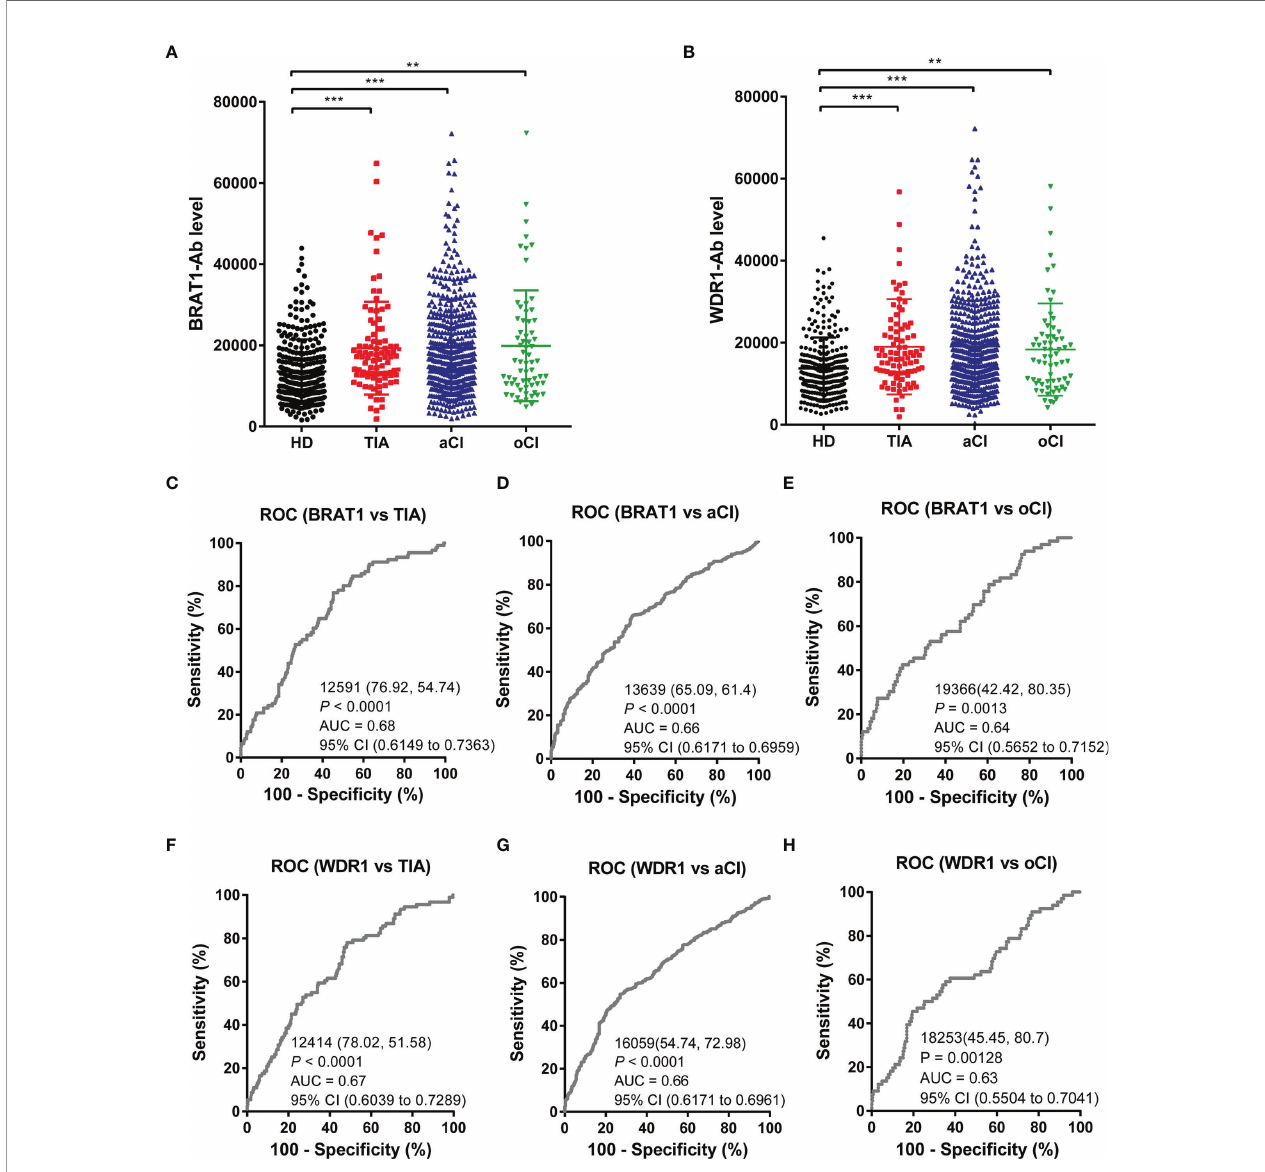
FIGURE 2 | Comparison of serum anti-BRAT1 antibody (BRAT1-Abs) and anti-WDR1 antibody (WDR1-Abs) levels between healthy donors (HDs) and patients with TIA, aCI, or oCI. Serum antibody levels against BRAT1-GST (A) or WDR1-GST (B) were determined by AlphaLISA. The bars represent the median. P values were calculated by the Kruskal – Wallis test. ** P < 0.01; *** P < 0.001. The serum numbers of HDs, TIA, aCI and oCI were 285, 91, 464 and 66, respectively. ROC analysis of BRAT1 and WDR1 for the prediction of TIA (C, F) , aCI (D, G) and oCI (E, H) . The numbers in the fi gures indicate the cutoff values for marker levels, and the numbers in parentheses indicate the sensitivity (left) and speci fi city